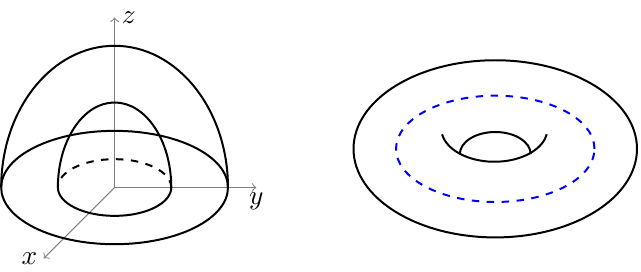
Figure 4 . (Color online) Left: the spherical coordinates on H 3 , which convert the original Schwarzschild metric (4.1) of BTZ black hole into the right picture. Right: topology of the Eu- clidean BTZ black hole is a solid torus. Horizon is the blue dashed line threading the central cord of the solid torus. The Euclidean time runs in the meridian